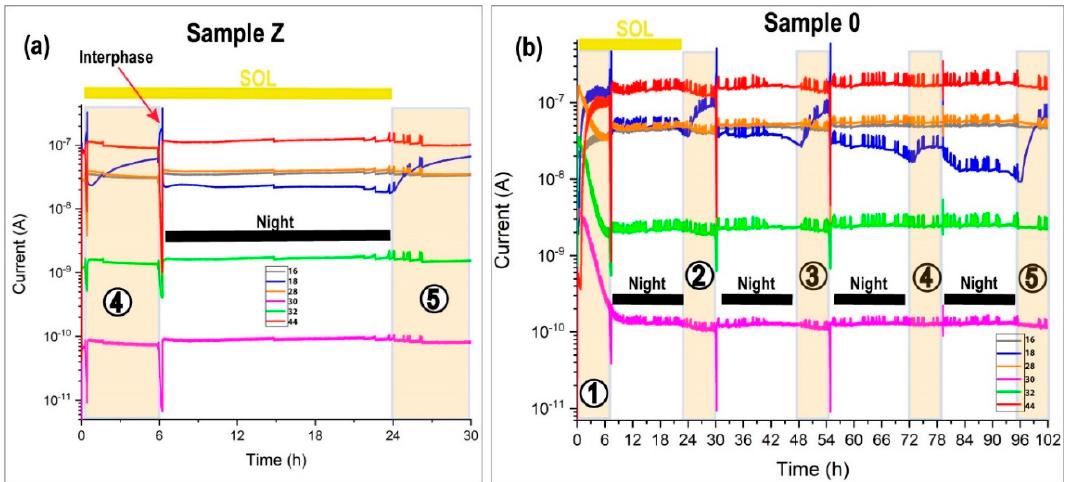
Figure 13. MID of samples Z and 0. The shaded areas correspond to daytime. The ions (q/m) 16, 18, 28, 30, 32, and 44 correspond mainly to oxygen, water, nitrogen, nitrogen dioxide, and carbon dioxide. The numbers correspond to the SOL number. The interphase is the region between de daytime and the nighttime. ( a ) MID of sample Z from the fourth dawn. ( b ) Complete MID of sample 0.